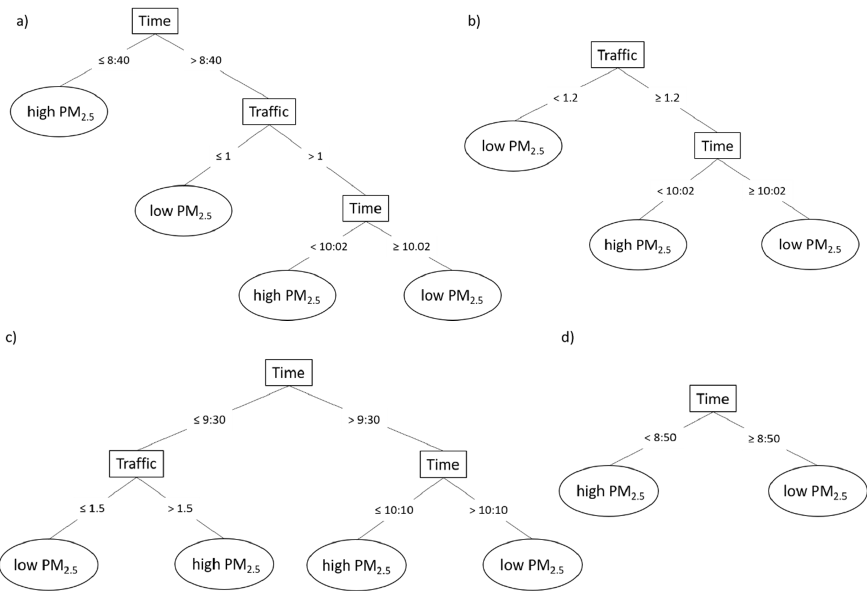
Figure 8. Decision tree models to predict the levels of concentration of PM 2.5 (high vs. low)